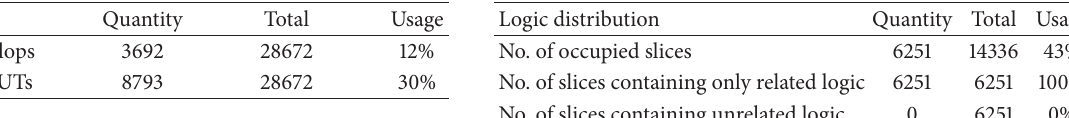
Table 11: Logic Utilization of SEA. Table 12: Logic distribution of SEA.